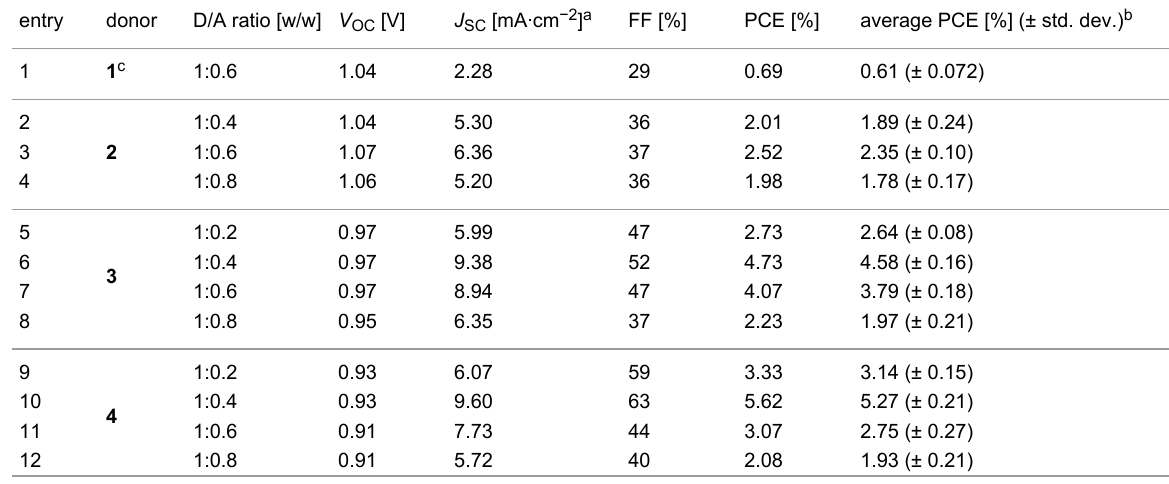
Table 2: Photovoltaic properties of COOP- n HT-TBDT:PC 61 BM-based devices. entry